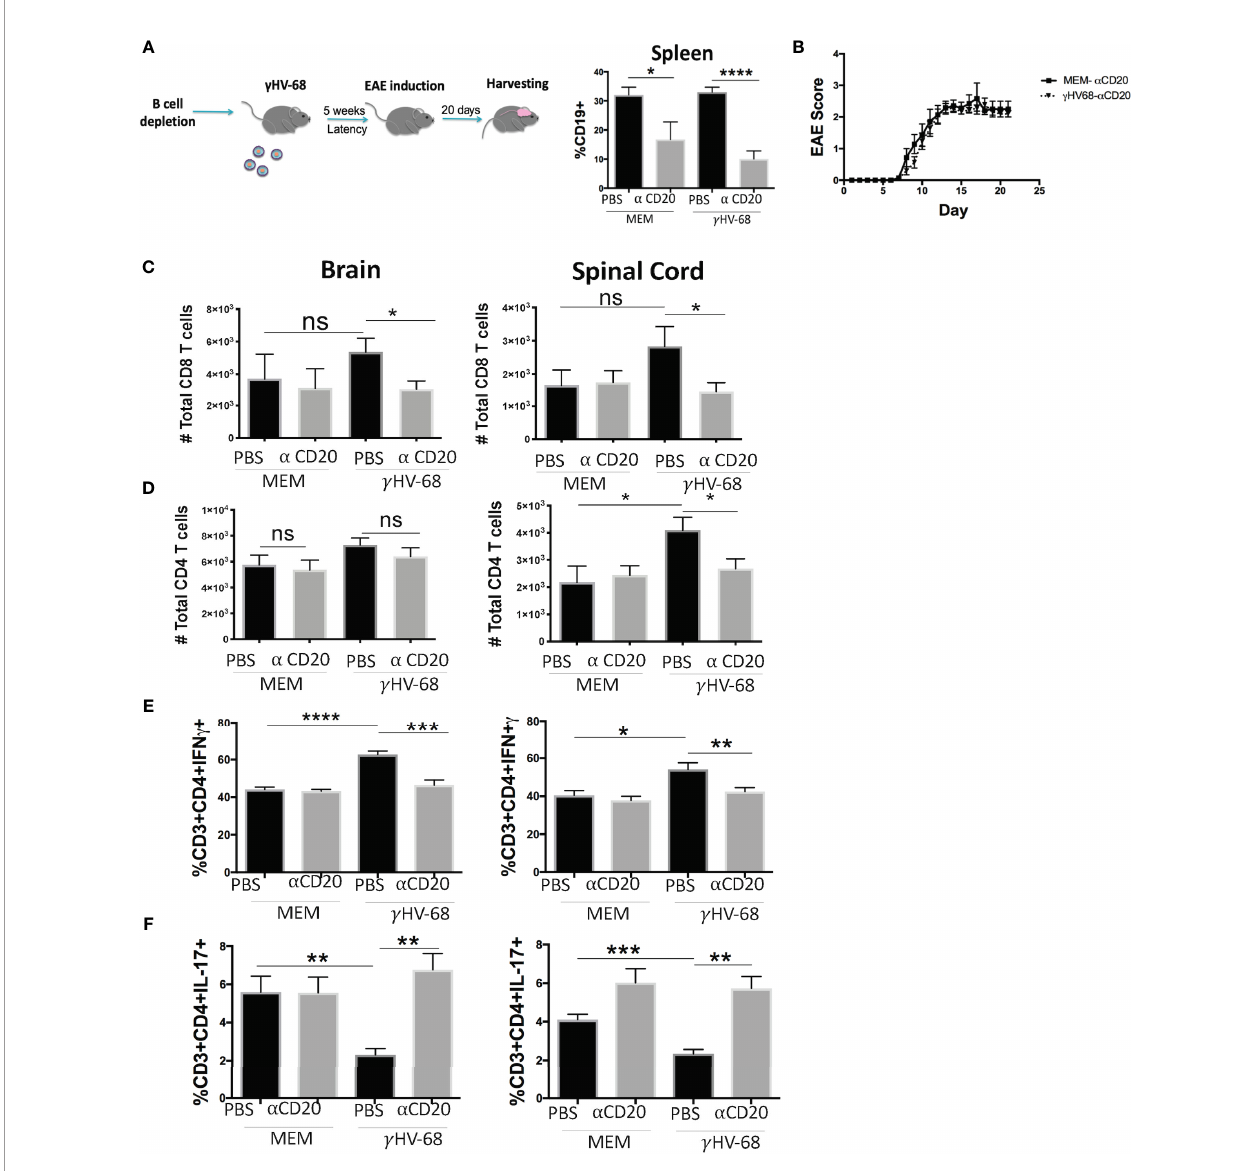
FIGURE 6 | B cells were depleted with a -CD20 i.v. 2 days after depletion, mice where infected with g HV-68 or MEM i.p. 5 weeks p.i. EAE was induced. At day 21 post EAE induction, mice were perfused; brains and spinal cords and spleen were harvested and processed to isolate immune in fi ltrates. (A) Histogram shows B cell levels at experimental end point. (B) Graph shows EAE scores up to day 21 post induction. (C) Total CD8 + in fi ltrating cells in the brain and spinal cord. (D) Total CD4 + in fi ltrating cells in the brain and spinal cord. Two independent experiments with 6 to 12 per group. (E) Percentage of CD3 + CD4 + IFN g + and (F) CD3 + CD4 + IL- 17 + in the brain and spinal cord. Two independent experiments with 5 to 12 mice/group. Data analyzed with Student ’ s t-test: ****p < 0. 0001, ***p < 0.001, **p < 0.01, *p < 0.05. ns = not signi fi